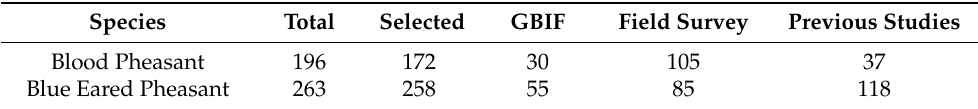
Table A1. Source of occurrence data used for the distribution modeling of the blood pheasant and the blue eared pheasant.